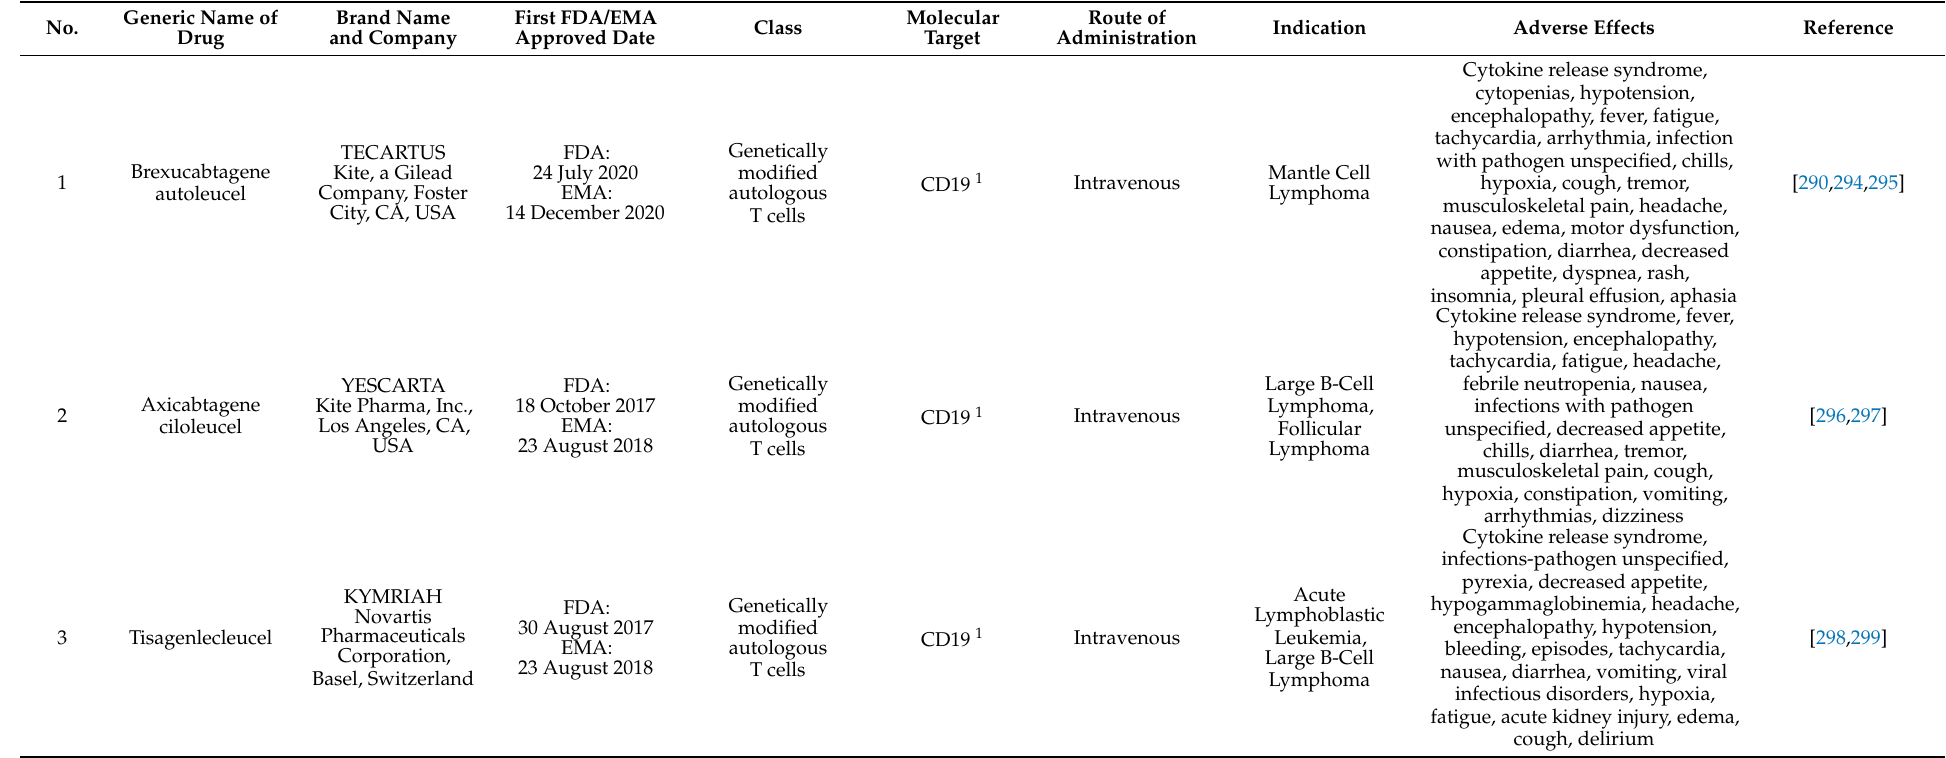
Table 16. Features of the chimeric antigen receptor T-cells (CAR-T cells) drugs approved by the Food and Drug Administration (FDA) from 2011 to 2021. The order of drugs is tabulated in order of most recent to oldest registration